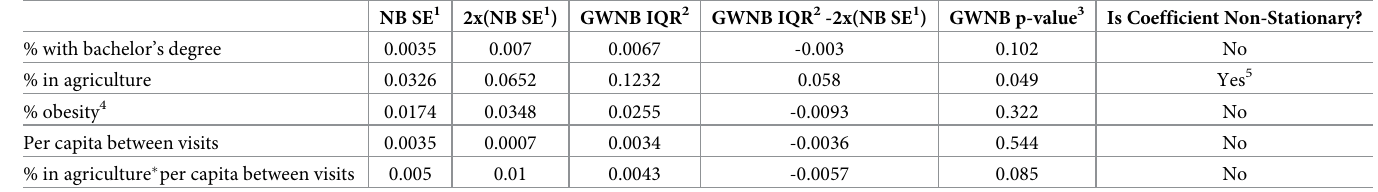
Table 4. Results of assessment of stationarity of the coefficients of the predictors of the COVID-19 risks in the Greater St. Louis Area, Missouri.